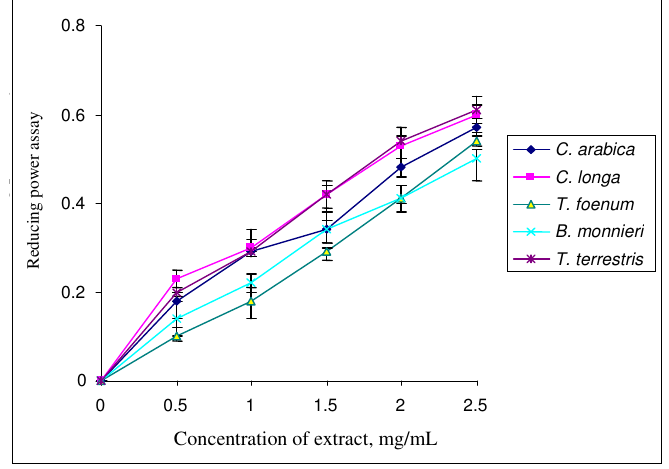
Figure 3. Inhibition of microsomal peroxidation data represents, mean ±SEM, for n=3